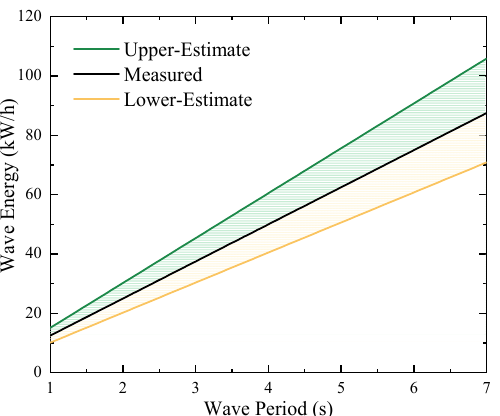
Figure 15. Wave energy estimate results of upper-estimate (green) and lower-estimate (yellow) with 5-m SWH measured values (black) in 2 – 6-s wave period.